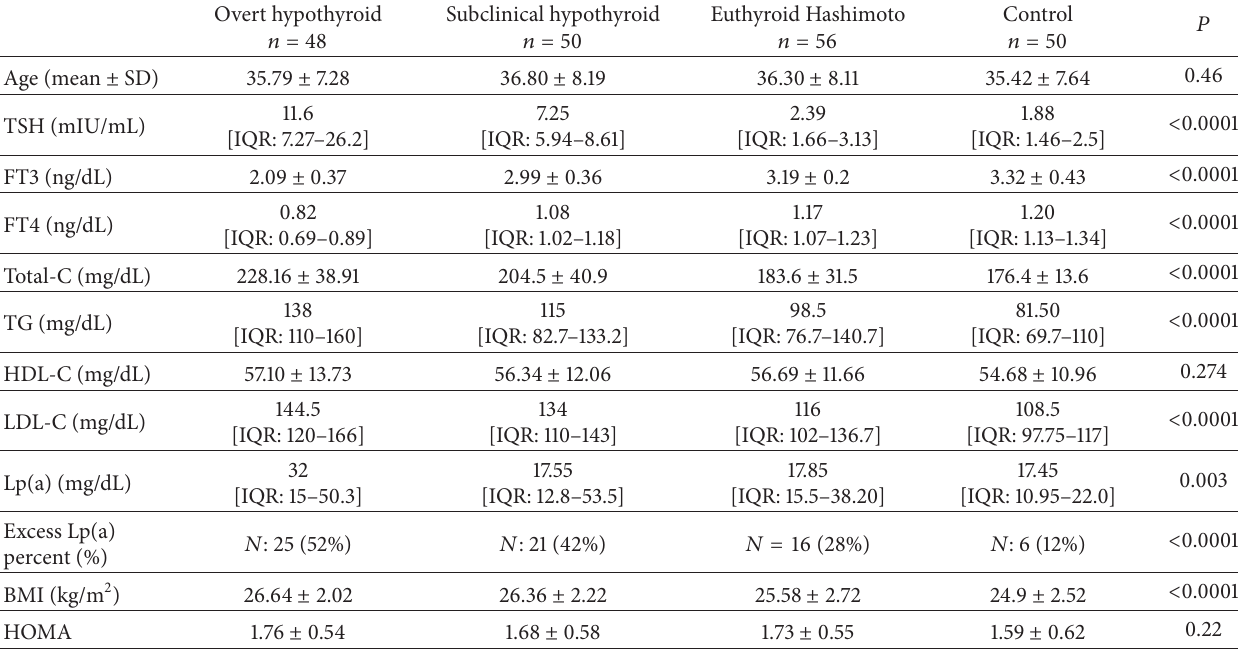
Table 1: Demographic and laboratory results of the